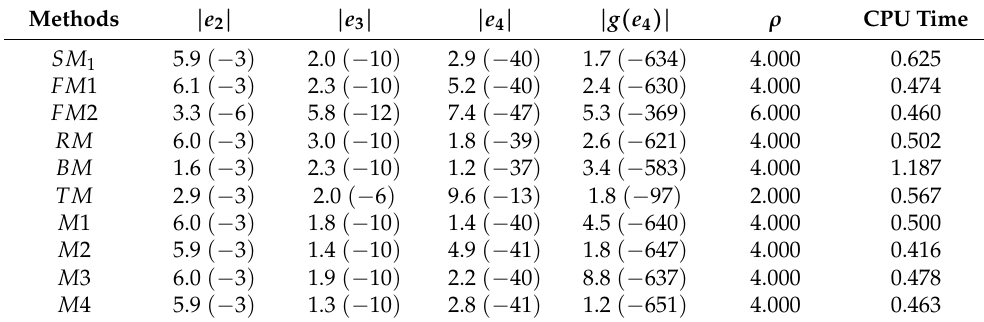
Table 4. The outcomes of Example 3 based on various methods with starting point x 0 = 3.1.